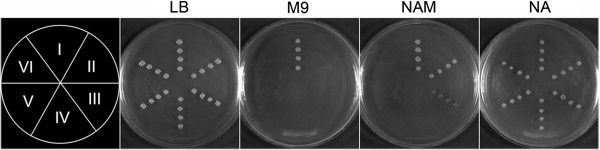
Growth of wild-type Escherichia coli (BW25113) and mutants in LB or M9 agar plates supplied with NAM or NA. Strains in area I-VI represent BW25113, BW25113ΔnadC, BW25113ΔnadCΔpncA, BW25113ΔnadCΔpncAΔxapA, BW25113ΔnadCΔpncAΔnadR and BW25113ΔnadCΔpncAΔxapAΔnadR, respectively. See Figure 1 for abbreviations.